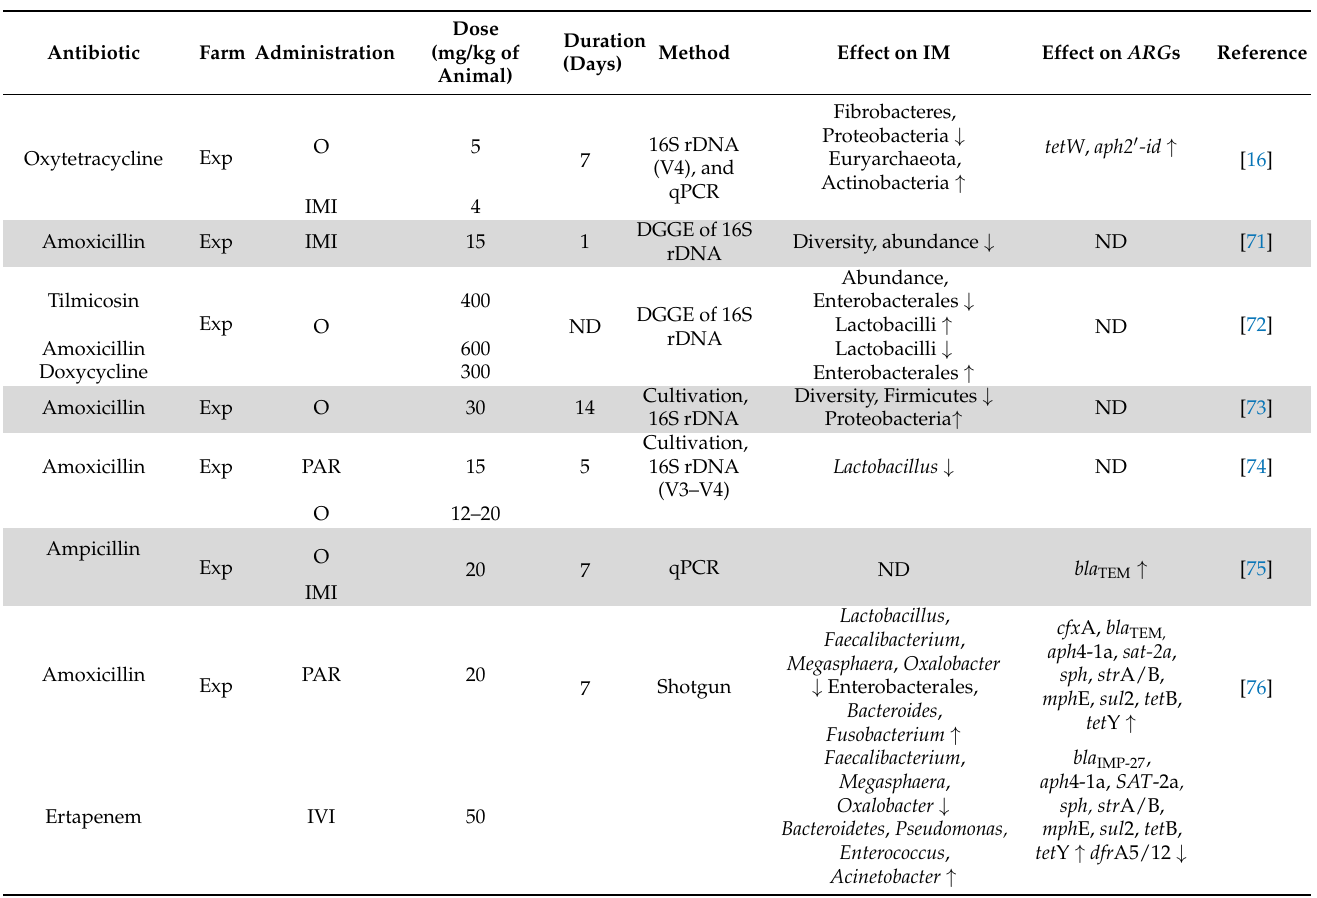
Table 2. Summary of studies investigating impact of antibiotics on pigs’ intestinal microbiota and relative antibiotic resistance